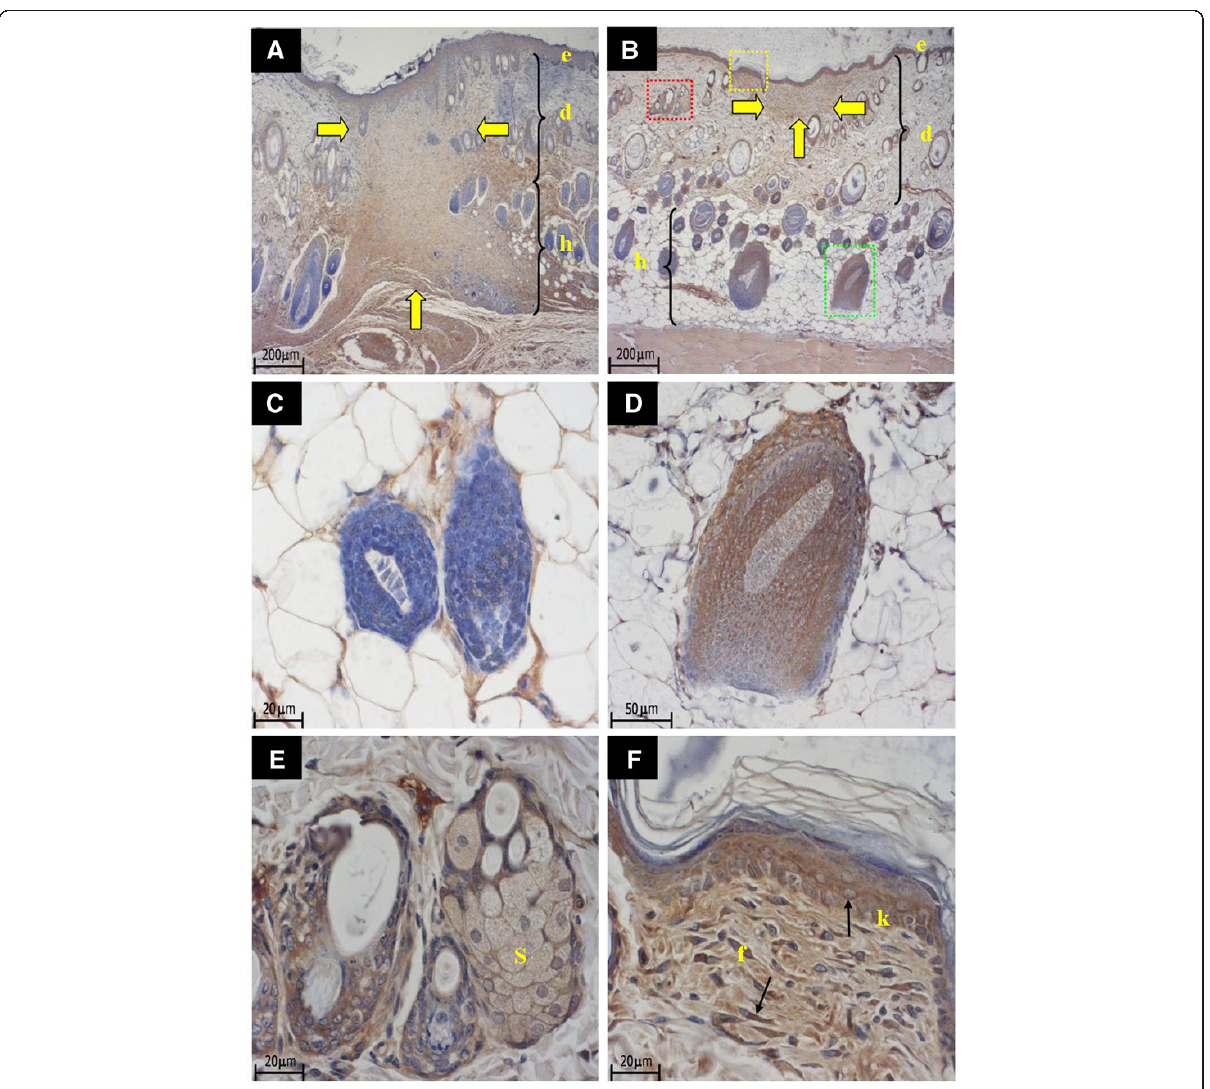
Figure 4 A-B. Sections from the dorsal skin of the Ovx, and the Ovx+YCJ groups, following treatment for 14 days. Sections were immunostained with anti-ER- α antibody. The yellow arrows indicate wound areas. Immunoreactivity is detected in keratinocytes, fibroblasts, sebaceous gland (red box), and hair follicle (green box). A = Ovx group; B = Ovx+YCJ group; e = epidermis; d = dermis; h = hypodermis. (4x). C- F . Higher magnification of B. C = non-immunoreactive hair follicles. (x40). D = Strong immunostaining of the hair follicle seen in the green box in B. (x20). E = Strong immunostaining of the sebaceous gland (S) seen in the red box in B. (x40). F = Strong immunostaining of keratinocytes (k) and fibroblasts (f) seen in the yellow box in B.